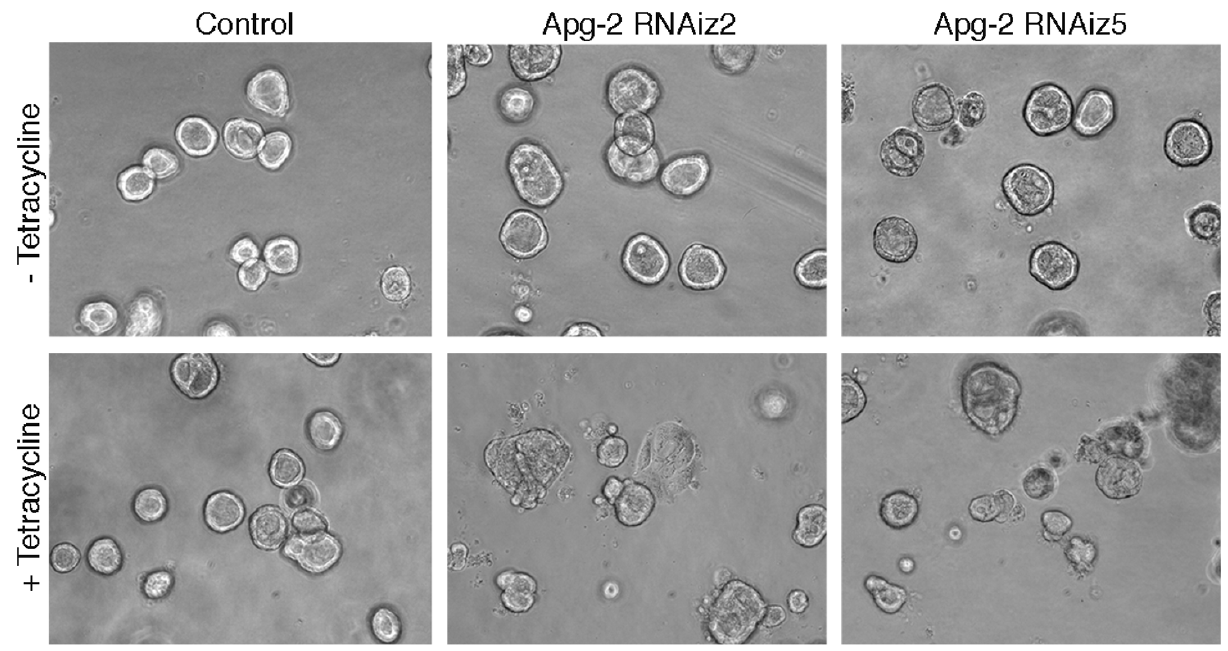
monitor cyst and lumen formation. The shown images were taken 7 days after the cultures had been started. Note, most cysts formed by Apg-2 depleted cells had an irregular shape and lacked a